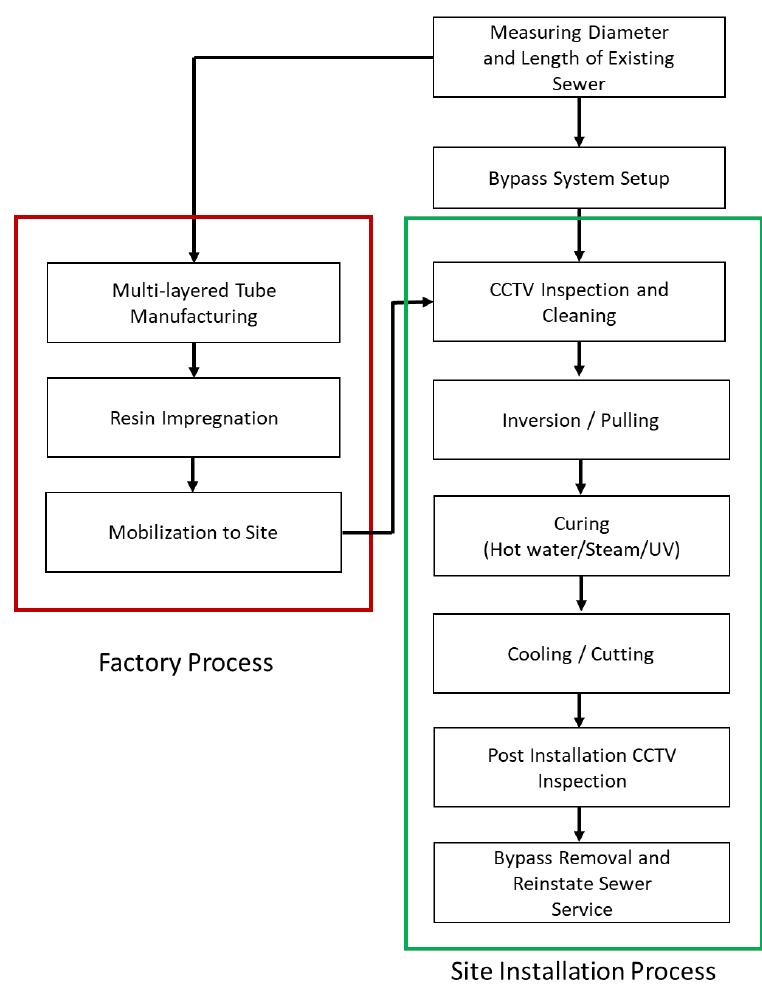
Figure 1. Cured-in-place pipe (CIPP) installation process.